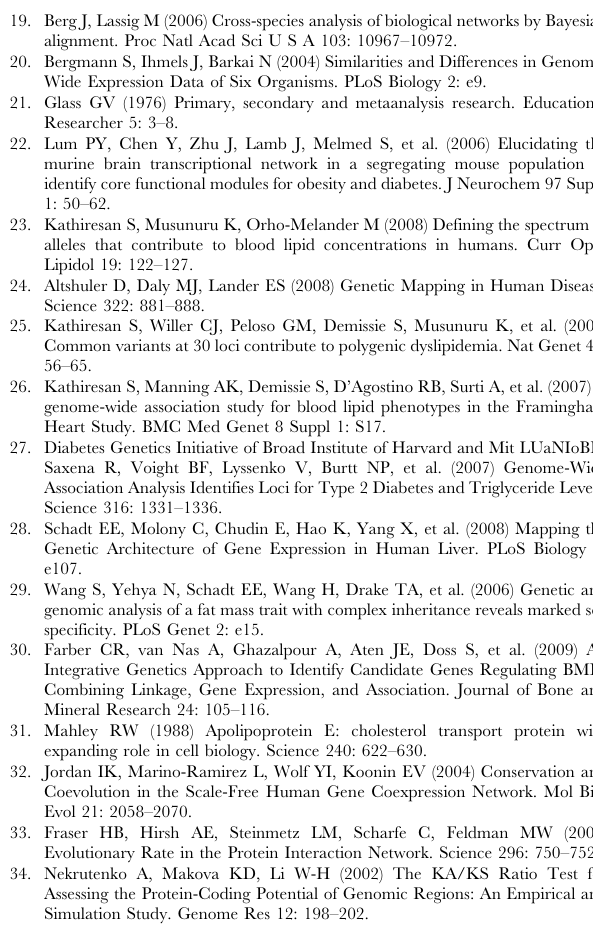
Table S8 Ordered rat gene symbols for genes shown in Figure S3C. Table S9 Number of predicted gene pairs that are significantly co-regulated at FDR , 0.024 for all existing meta-analysis methods and the proposed method. ‘%GO’ indicates the percent of gene pairs sharing a common specific Gene Oncology biological process category. The background percentage is 0.0413 for randomly selected gene pairs that share common GO biological processes. FEM Fisher-Z: the fixed effect model based on Fisher-Z transformation; REM Fisher-Z: the random effect model based on Fisher-Z transformation; Combine P-value: combine p-values of Fisher’s Inverse x 2 tests; Order Statistic: Order-based non- parametric meta-analysis; d-statistics: the semi-parametric meta- analysis. See Methods section for details of individual methods. Table S10 The qualities of top predicted pairs based on existing meta-analysis methods and the proposed method. 20,230 was chosen based on the proposed semi-parametric method at the false positive rate 0.05. ‘%GO’ indicates the percent of gene pairs sharing a common specific Gene Oncology biological process category. ‘%KEGG’ indicates the percent of gene pairs sharing a common KEGG pathway. The abbreviations of different meta- analysis methods are the same as Table S9.